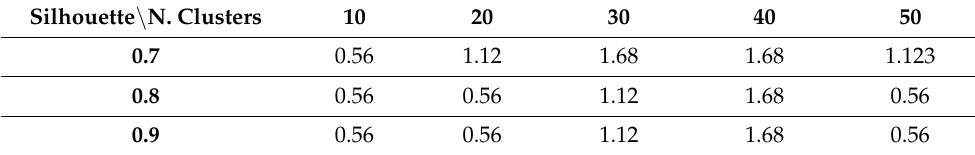
Table 28. Clustering performance in terms of silhouettes using normalized data. Silhouette \ N. Clusters